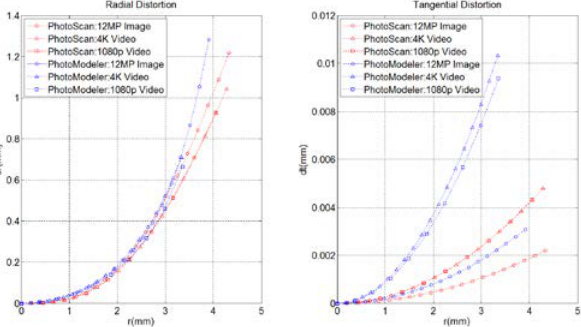
Figure 3. Results of lens distortions using different modes and different methods.